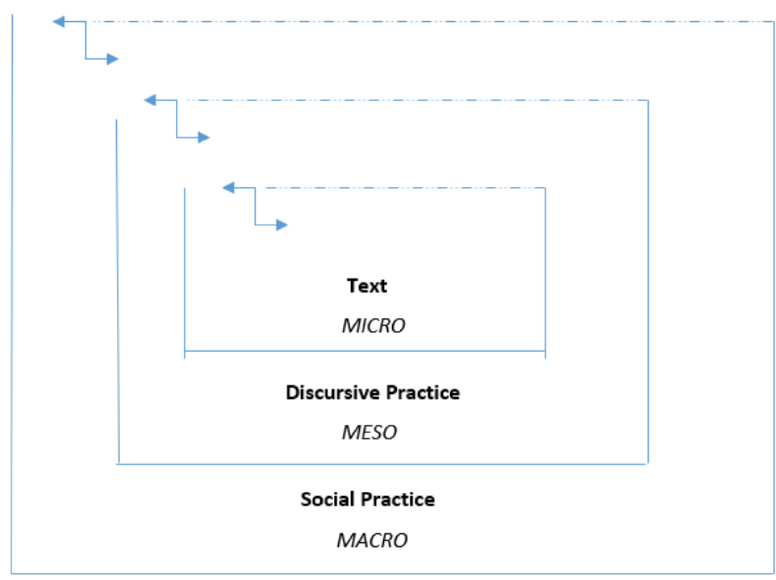
Figure 1. Theoretical framework. Adapted from Fairclough (1993, p.